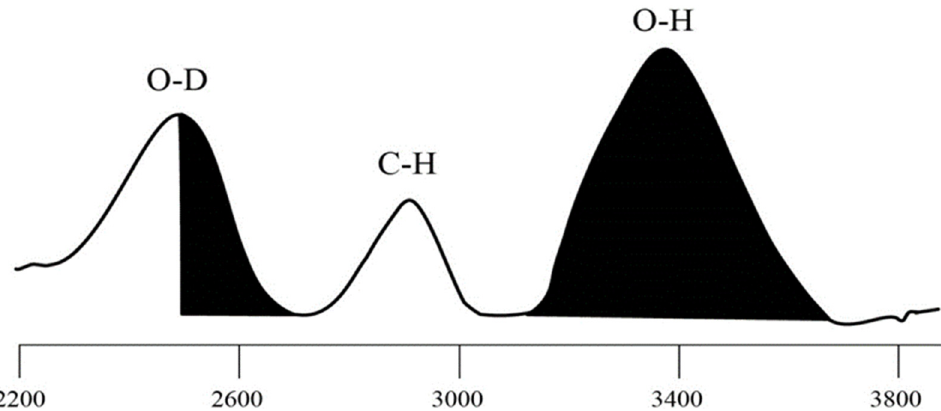
Figure 1. An example ATR-FTIR spectrum in the range of 2200–3800 cm − 1 of deuterated Scots pine after exposure to D 2 O. The surface area marked were used for calculating the accessible hydroxyl group. To avoid contribution from CO 2 vibration at the range of 2300–2400 cm − 1 . Only the area between 2700 cm − 1 and height wavenumber (approx. 2510 cm − 1 ) was determined and doubled modified from [30].